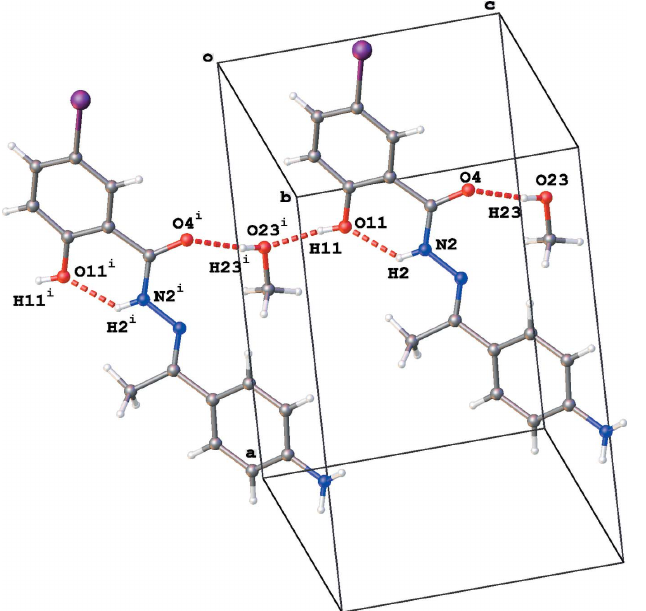
Figure 2 Part of the crystal packing of the title compound, showing the chain along the c -axis direction formed by O—H (cid:2)(cid:2)(cid:2) O hydrogen-bonding interactions [see Table 1; symmetry code: (i) x , y , z (cid:4) 1]. Only the major component of the disordered methyl group C14 is shown.